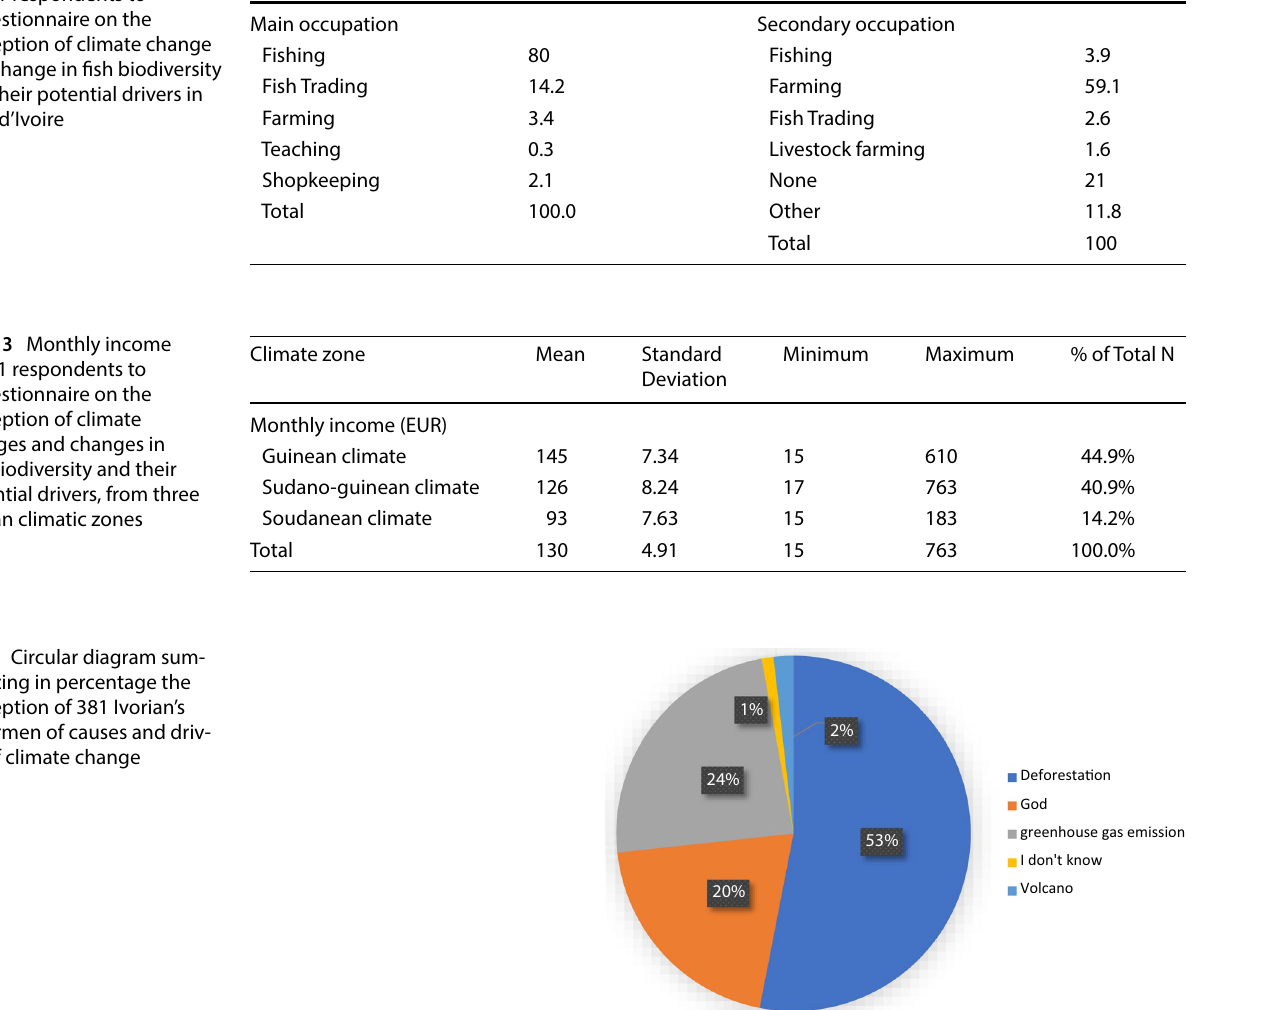
Table 2 Livelihood strategies of 381 respondents to a questionnaire on the perception of climate change and change in fish biodiversity and their potential drivers in Côte d’Ivoire